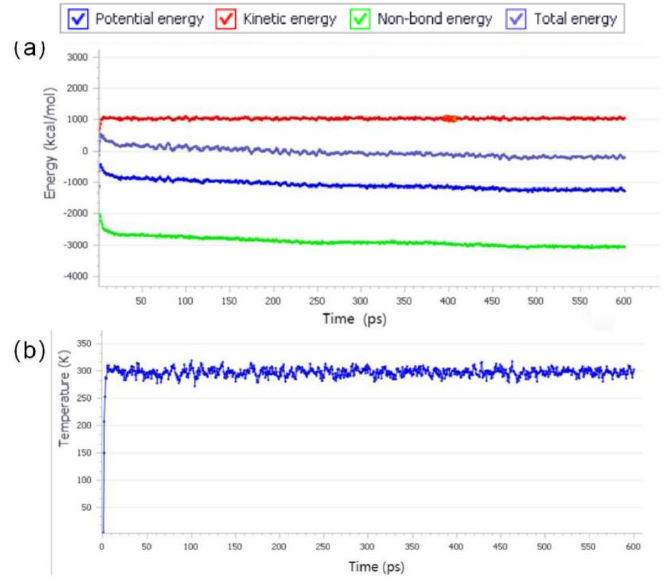
Figure 4. ( a ) Dynamic energy curves of model in NVT ensemble; ( b ) temperature curves of model in NVT ensemble.